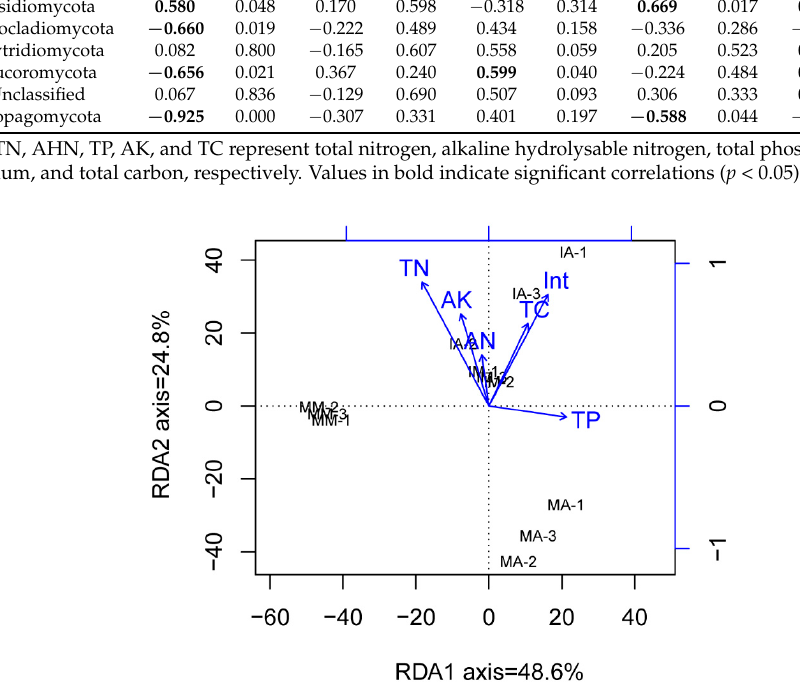
Figure 6. Redundancy analysis (RDA) plot of soil variables, intercropping and soil fungal community in soils from different treatments. The RDA plot was calculated from the relative OTU abundances and soil properties. Arrows of the RDA plot indicate the direction and magnitude of measurable variables associated with fungal community structures. Each word represents a sample. TN had the longest arrow indicating it was the most important in all the shown factors affecting the fungal community. RDA component 1 and 2 explained 48.6% and 24.8% of the total variations of the fungal